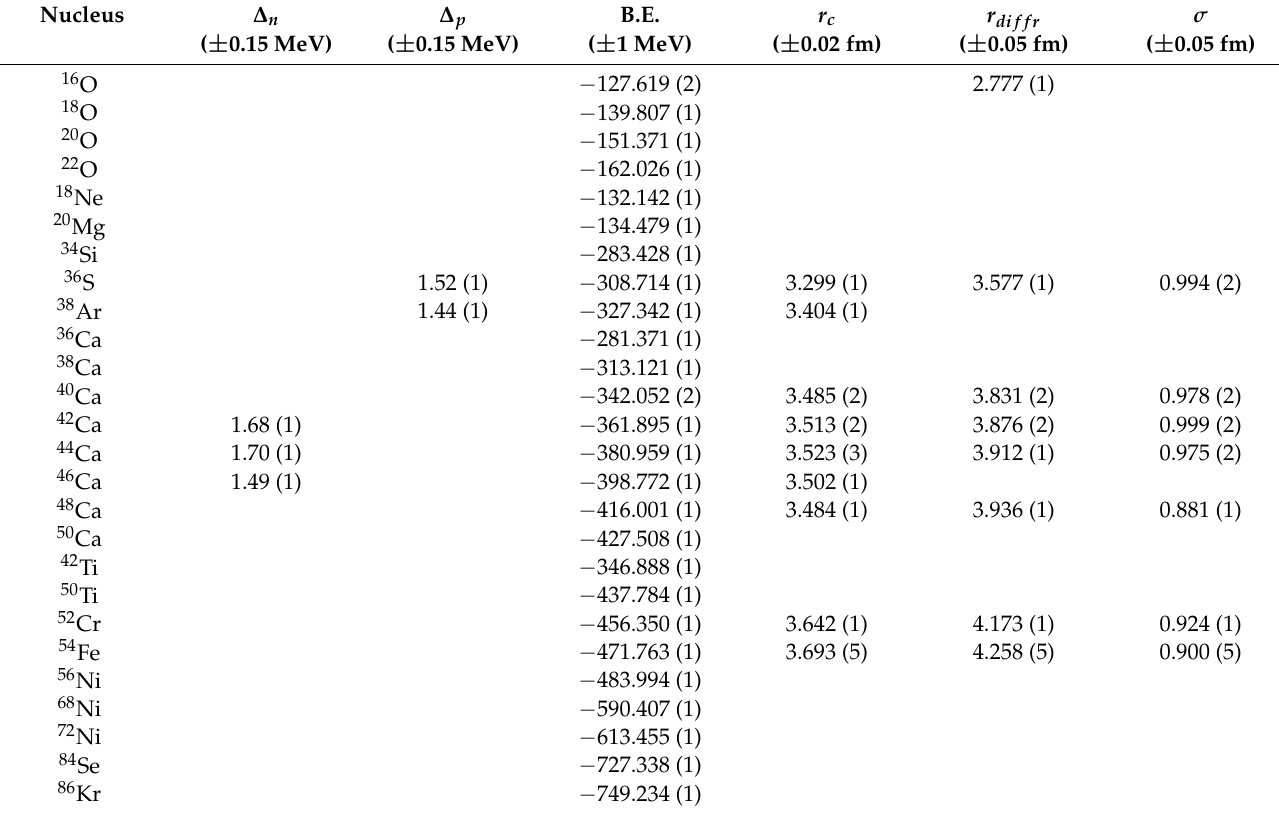
Table 1. The experimental data for the binding energies (B.E.) (72 nuclei) [46,47] and charge radii r c (36 nuclei) [48] are used alongside with the neutron (15 nuclei) and proton (14 nuclei) mean gap values ∆ n ( p ) , diffraction radius r dif fr (22 nuclei), and surface thickness σ (18 nuclei) values for the selected nuclei [28] in the fitting of the DD-PC ( J = 29, 30, ..., 36 MeV) functionals. In the second line, we display the adopted errors for each observable. The adopted error is also multiplied by a further integer weight factor that is given in the parentheses next to each